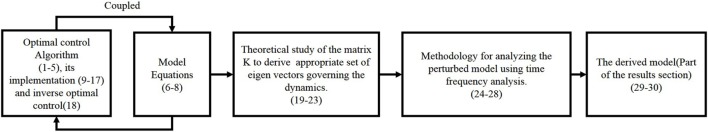
Flowchart shows how the set of equations (1)–(30) are used. The equation numbers are given in brackets. The optimal control and model equations cannot be fully separated to have one causally influencing the other, therefore, it is shown as coupled. The last two equations come from the results section, which depicts the derived functional.